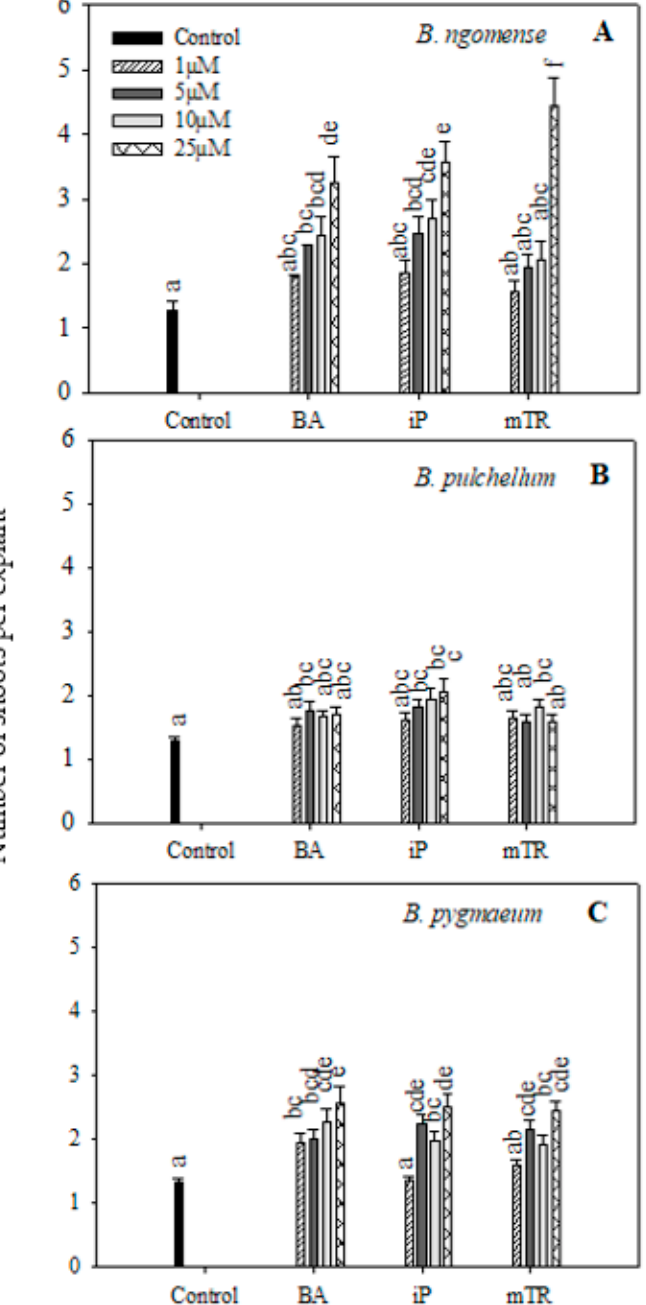
Figure 1. Effect of varying concentrations of cytokinins on shoot production in ( A ) Brachystelma ngomense , ( B ) Brachystelma pulchellum and ( C ) Brachystelma pygmaeum after six weeks in culture. In each graph, different letter(s) on the bars show significant differences according to Duncan’s multiple range test (DMRT) ( p ≤ 0.05). N 6 -benzyladenine (BA), isopentenyladenine (iP) and meta -topolin riboside ( m TR).